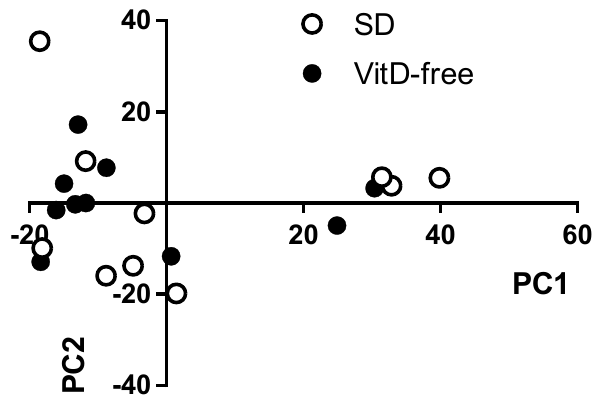
Figure 3. E ff ects of vitamin D-free diet on bacterial β -diversity. β -diversity was analyzed using the principal coordinate analysis (PCA) of the standard diet group using PAST3.0. The principal components PC1 and PC2 are plotted in a bidimensional figure. The white spheres represent rats fed a standard diet (SD, n = 10) and black spheres rats fed a vitamin D-free diet ( n = 10).